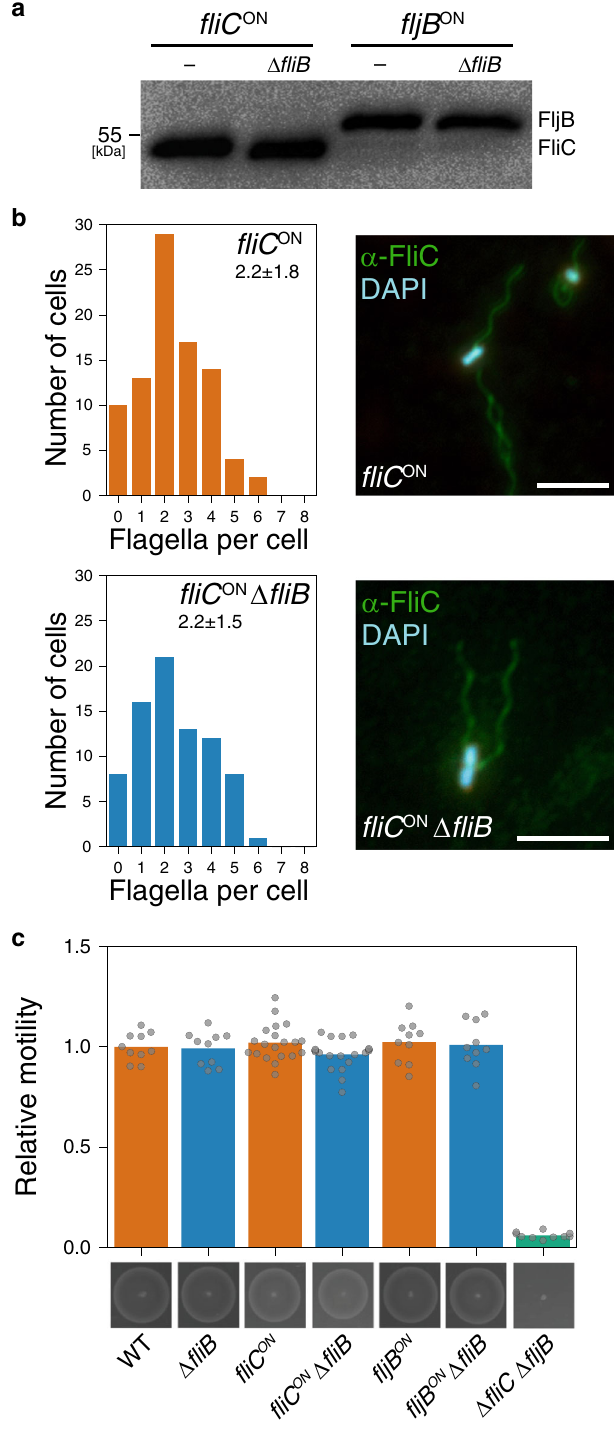
reasoned that the addition of hydrophobic methyl groups to surface-exposed lysine residues (Fig. 2, Supplementary Fig. 9) might affect the hydrophobicity of the fl agellar fi lament and through this mechanism promote bacterial adhesion to hydro- phobic molecules present on the surface of epithelial cells. Con- sistently, the surface hydrophobicity (So) of puri fi ed FliC and FljB fl agella was signi fi cantly reduced in the absence of lysine methylation (Fig. 5a, b).